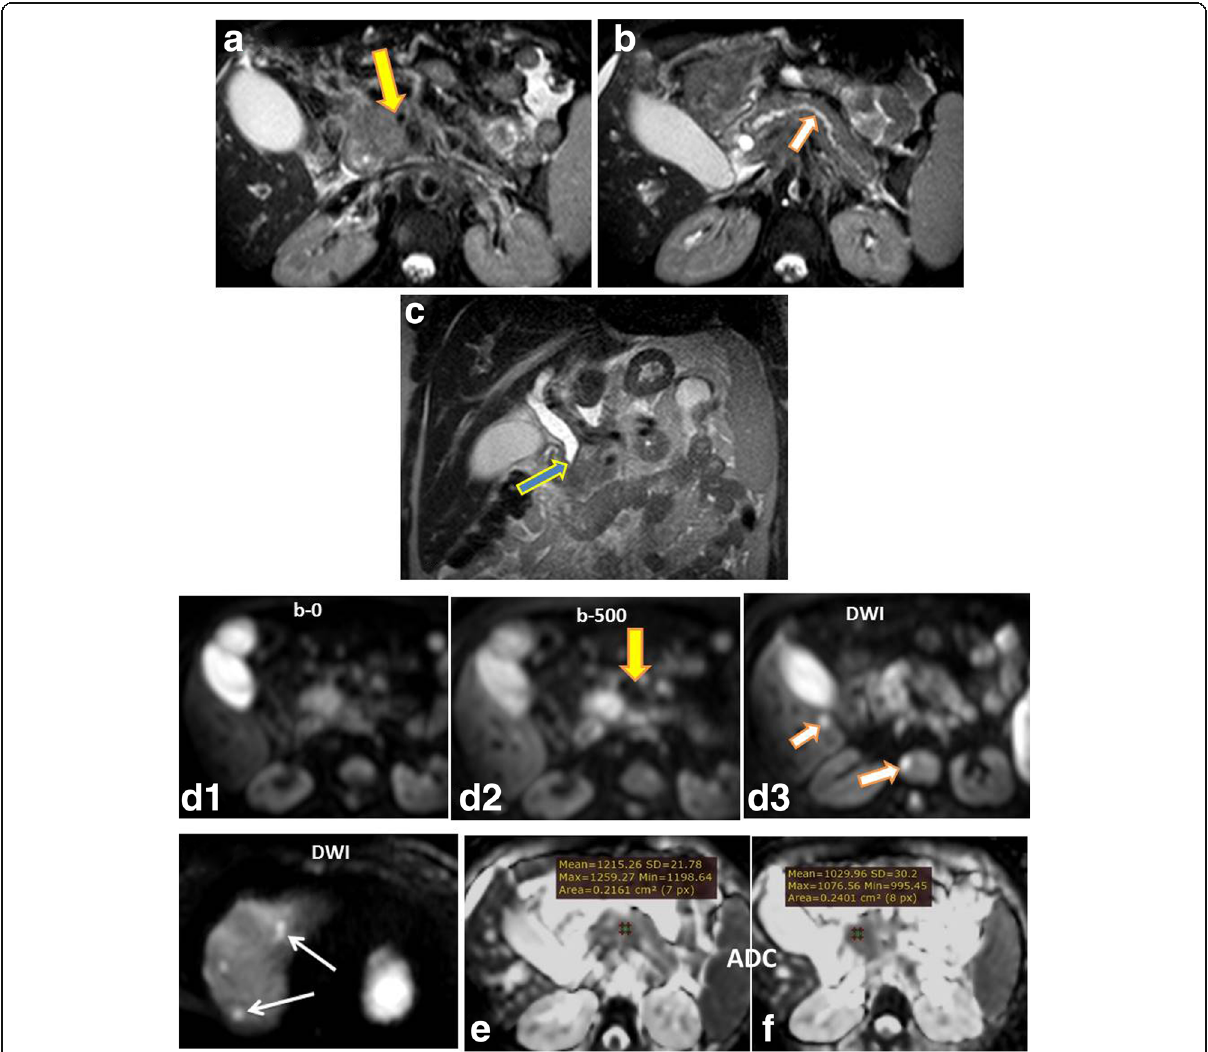
Fig. 3 A 73-year-old female patient presented by obstructive jaundice. a – c Conventional images (axial and coronal T2WI) showed isointense signal intensity lesion involving the pancreatic head with encasement of the mesenteric vessels >180° (yellow arrow). Dilated CBD down to its lower end (arrow in c ). d – f ) DWI and ADC maps revealed truly restricted pancreatic head mass with increased brightness with increasing of the b value denoting its malignant nature. The vascular encasement here appeared to be <180° (resectable lesion). Multiple hepatic ( d4 ) and bone ( d3 ) deposits are detected rendering the lesion unresectable. The ADC value of the lesion ranged from 1.0 to 1.2 × 10 − 3 mm 2